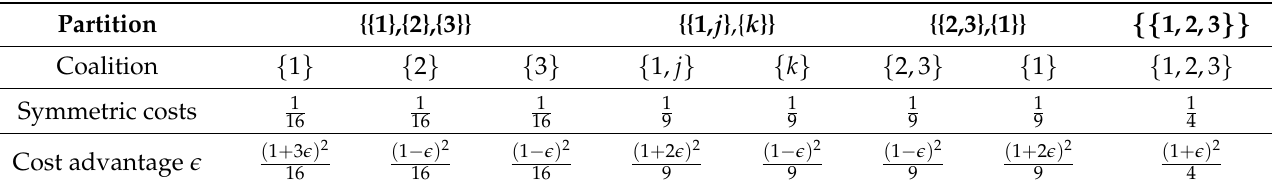
Table 1. Profits in Cournot competition with three